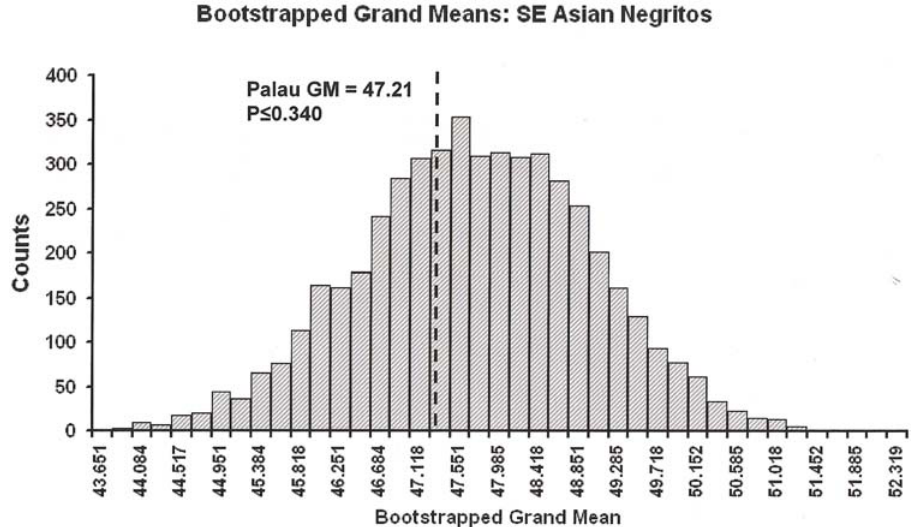
Figure 3. Bootstrapped Grand Means (n=5000) for the SE Asian Negritos. Table S1 Pooled-Sex descriptive statistics for the African Pygmy and Southeast Asian Negrito samples Table S2 Randomization comparisons of the small-bodied comparatives. Table S3 Randomization comparisons of the small-bodied comparatives. Table S4 Randomization comparisons of the small-bodied comparatives. Figure S1 Found at: doi:10.1371/journal.pone.0003939.s005 (3.68 MB TIF)